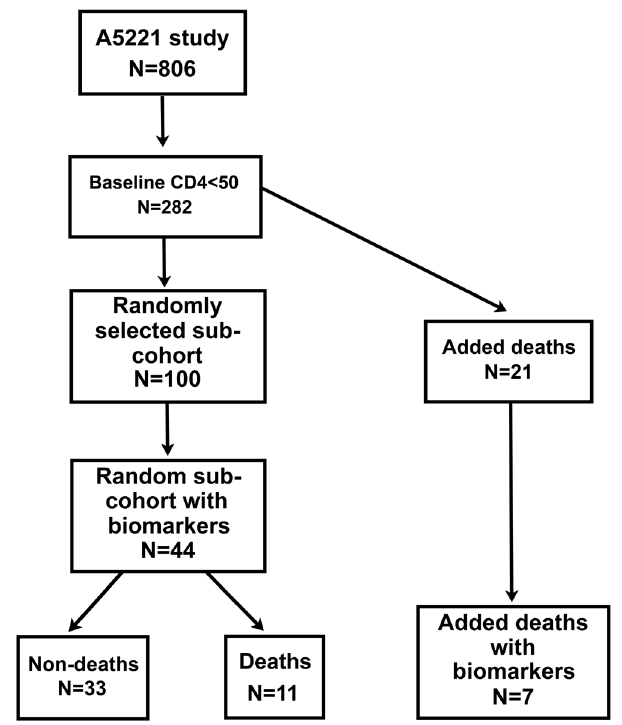
Figure 1. Schema for Selection of the Case-Cohort. A random cohort consisting of 100 participants was drawn from a subset of the 806 study participants who had CD4 < 50 cells/mm3 (n = 282). Plasma was only available for 44 participants in this subset, 11 of whom died. This cohort was enriched by selecting 21 additional cases from the 282 participants having CD4 < 50 cells/mm3 (not in the random cohort of 100) who also died, but only seven of these had plasma. The total case-cohort for the study therefore included 51